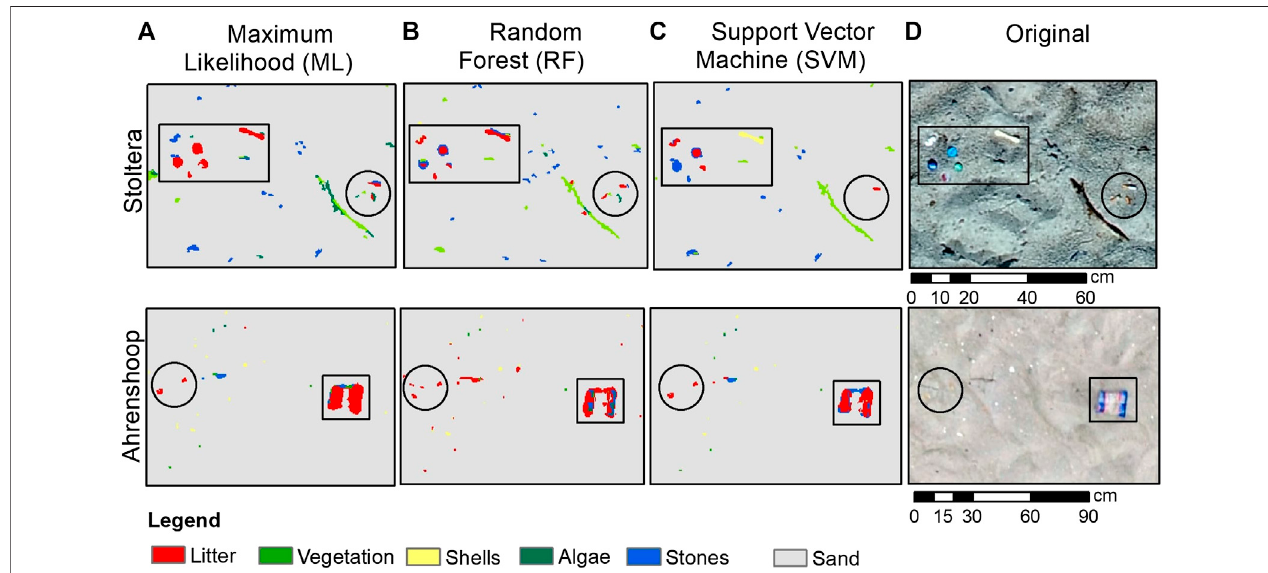
FIGURE 5 | Comparison of supervised classi fi cation with six classes with the algorithms ML, RF, and SVM on erial images at 10 m for the site Stoltera and Ahrenshoop. Each close-up image shows the distribution of litter objects on the recovery site (D) and their classi fi cation result (A – C) , such as litter objects of different sizes (square) and cigarette butts (1 – 2.5 cm)